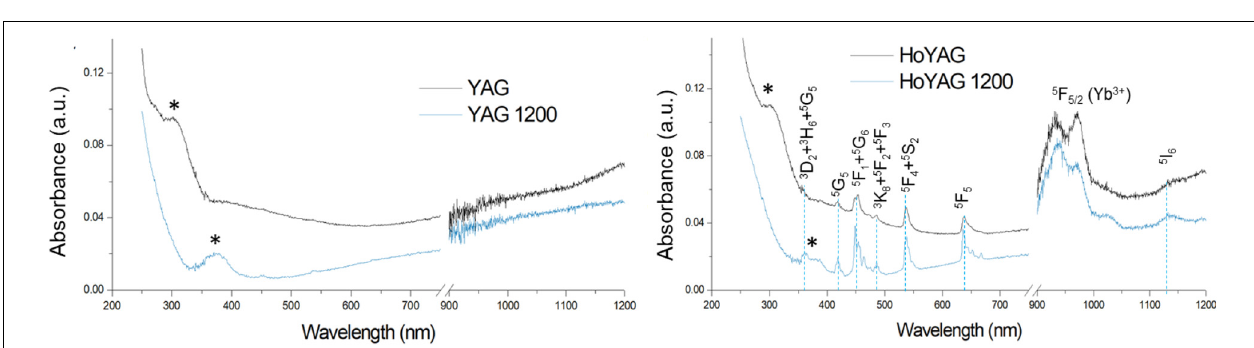
FIGURE 3 | Absorption spectra of as-synthesized and annealed YAG and HoYAG samples. Absorptions from garnet surface defects (*) and electronic 4f–4f transitions from Ho 3 + and Yb 3 +